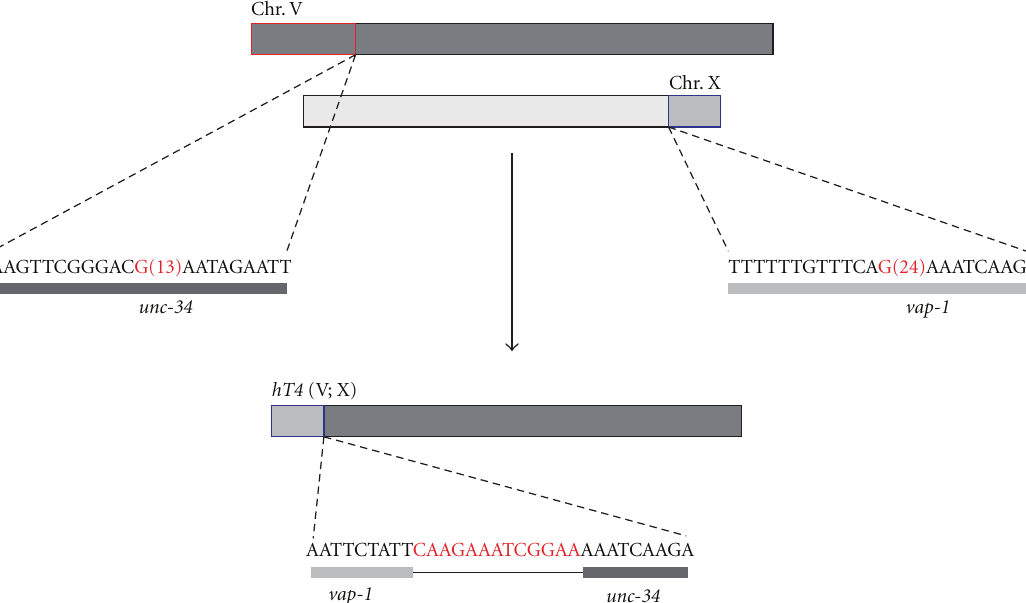
Figure 1: Schematic of the dog-1 -derived translocation, hT4 (V; X). Sequences near the left end of chromosome V were deleted (red box), whereas the right end of chromosome X was duplicated (blue box). PCR primers were designed and used to determine the DNA sequence across the junction of V and X in hT4 (described in